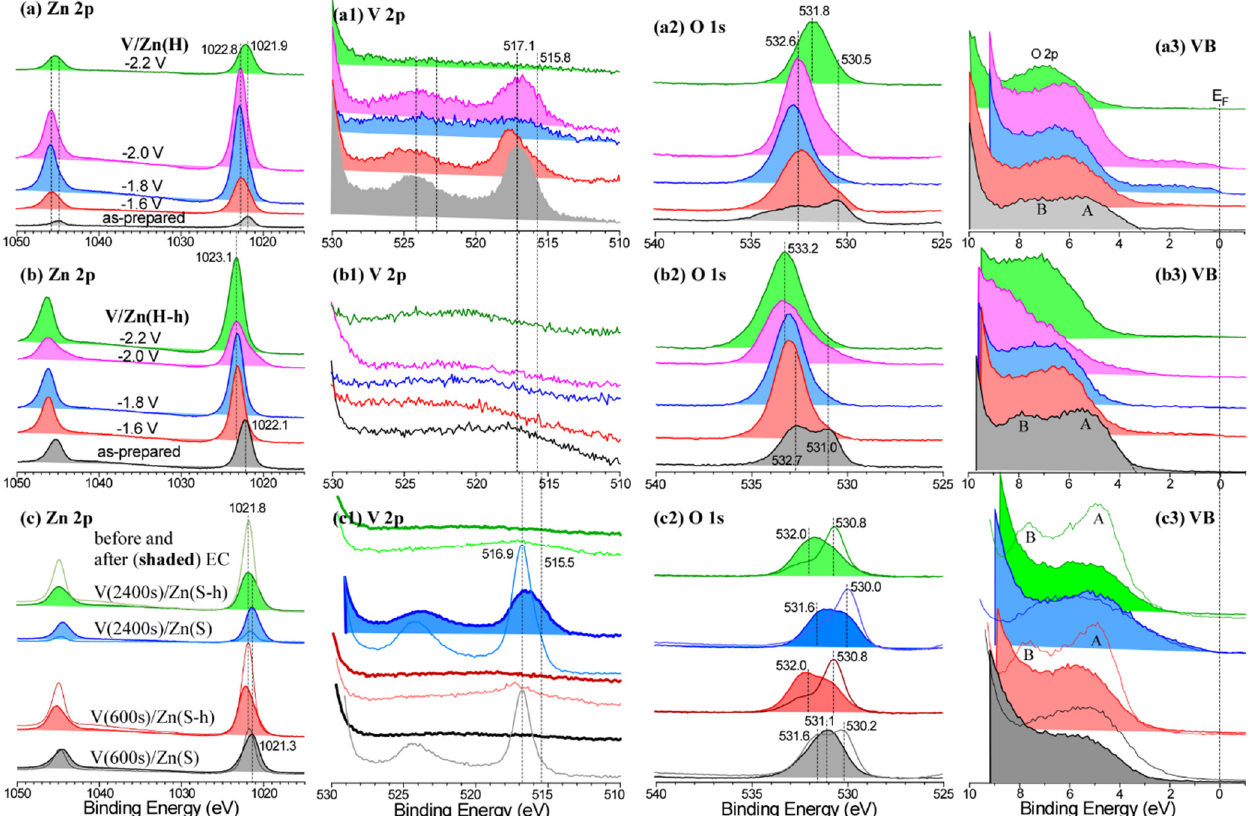
Figure 7. Zn 2p, V 2p, O 1s, and VB XPS profiles for V/Zn(H) electrode before and after tested at various applied potentials (( a – a3 ), respectively), V/Zn(H-h) electrode before and after tested at various applied potentials (( b – b3 ), respectively), and V(600 s)/Zn(S), V(600 s)/Zn(S-h), V(2400 s)/Zn(S), V(2400 s)/Zn(S-h) electrodes before and after EC (shaded area) at − 1.6 V in 0.1 M KHCO 3 electrolyte (( c – c3 ), respectively).